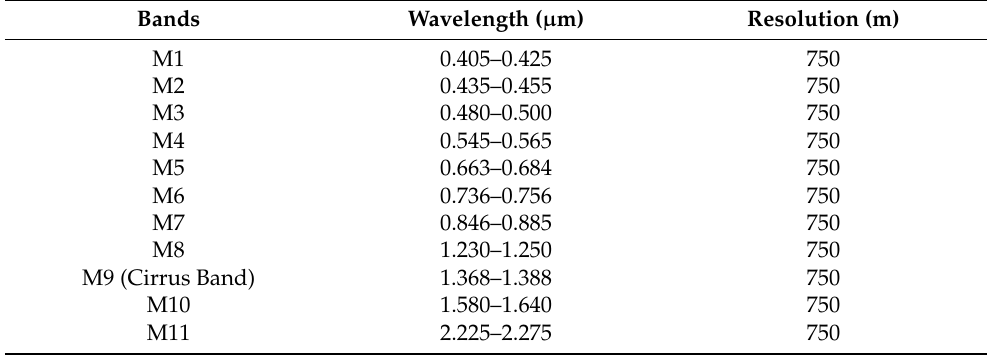
Table 1. The names, widths, and spatial resolution (m) of some VIIRS bands.